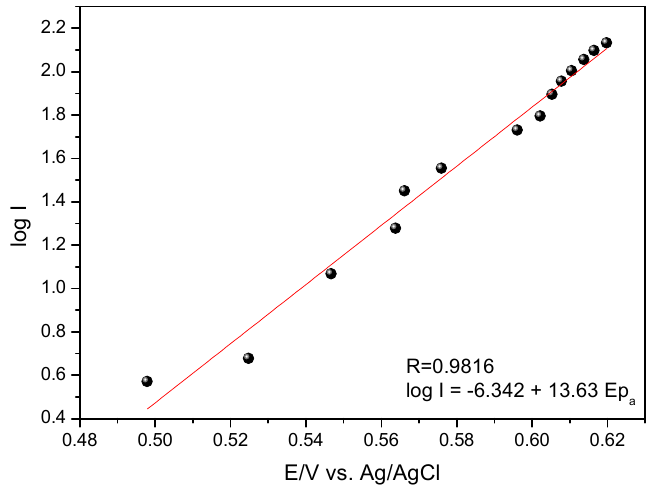
Figure 9. Tafel curve for the ECV-NTCPM-CoPc system in the presence of Ethinyl estradiol. Relationship between current log and potential.